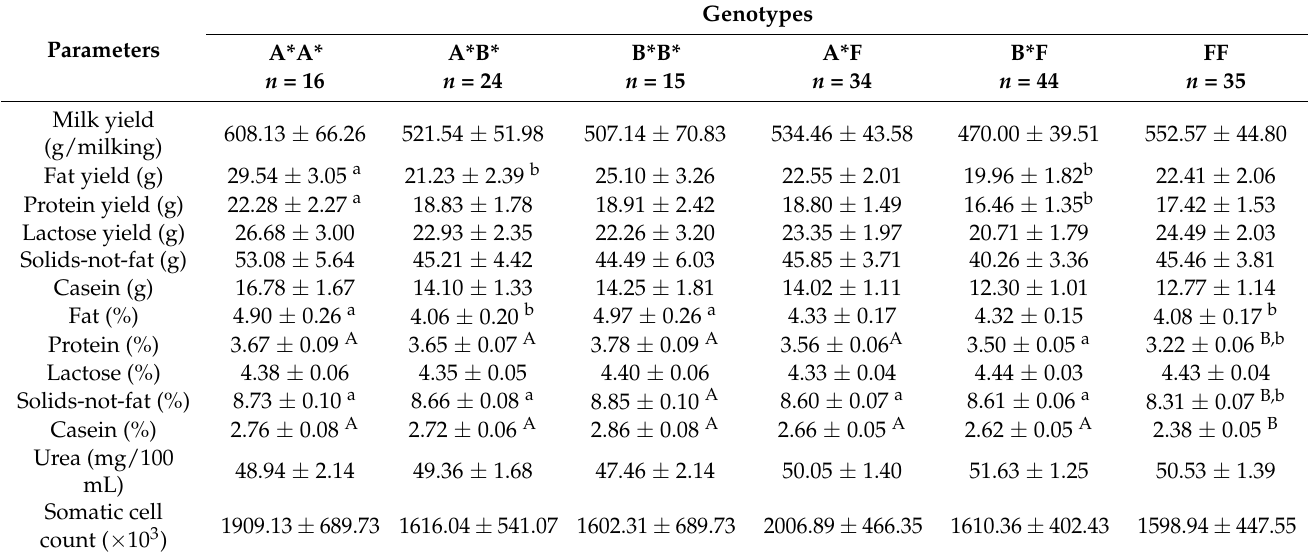
Table 2. Effect of different genotypes at the CSN1S1 locus on milk yield and composition of all the animals